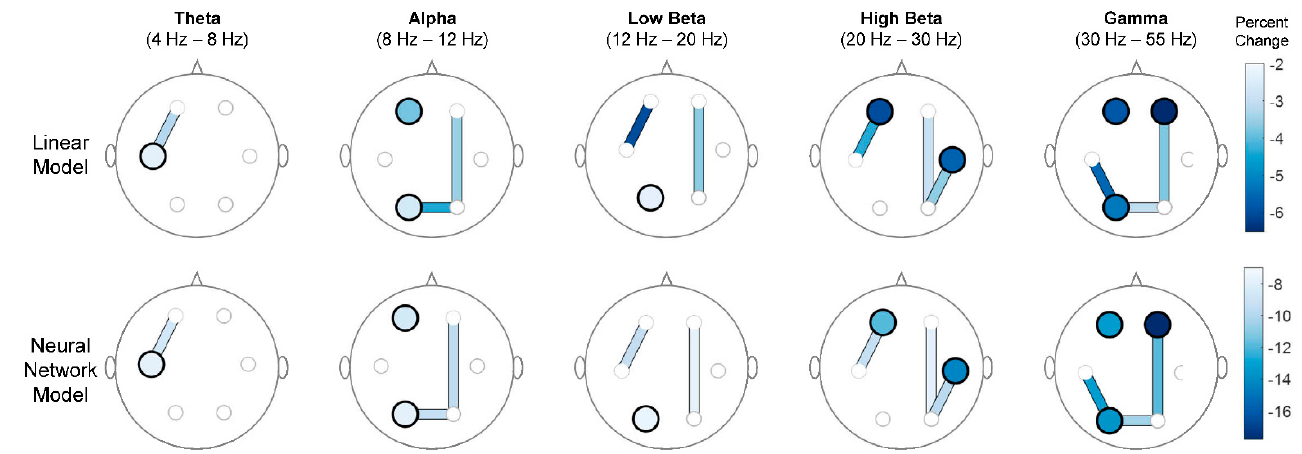
Figure 8. Sensitivity analysis for both the linear and neural network models. The color bar indicates the percent change in model performance (Pearson correlation coefficient) when each feature was systematically